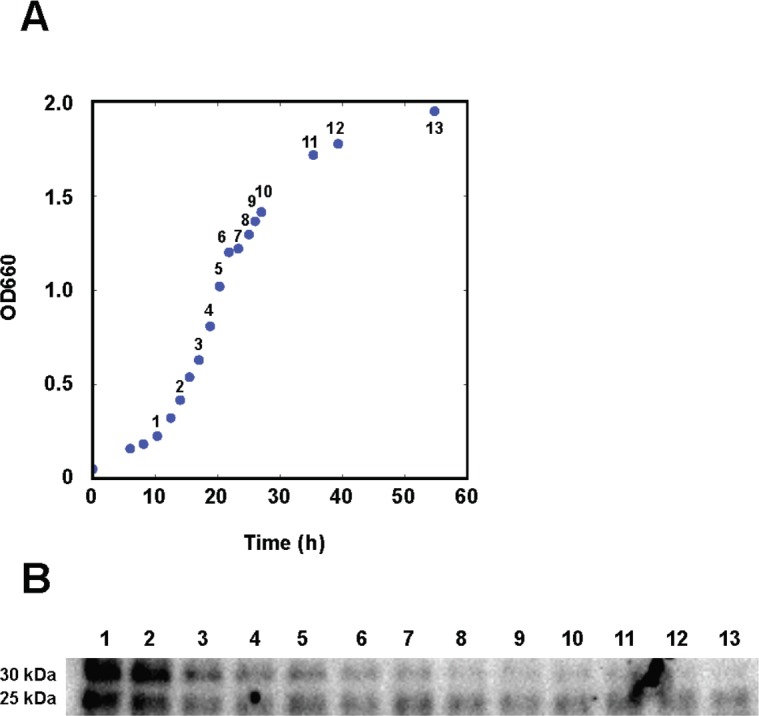
AerR also exists as two forms under photosynthetic growth conditions.(A) R. capsulatus grown under aerobic conditions with AerR-FLAG protein expression checked at each point (1 to 13 in growth curve). (B) Western blot analysis to detect AerR-FLAG protein. Lane numbers are responding numbers in the growth curve.